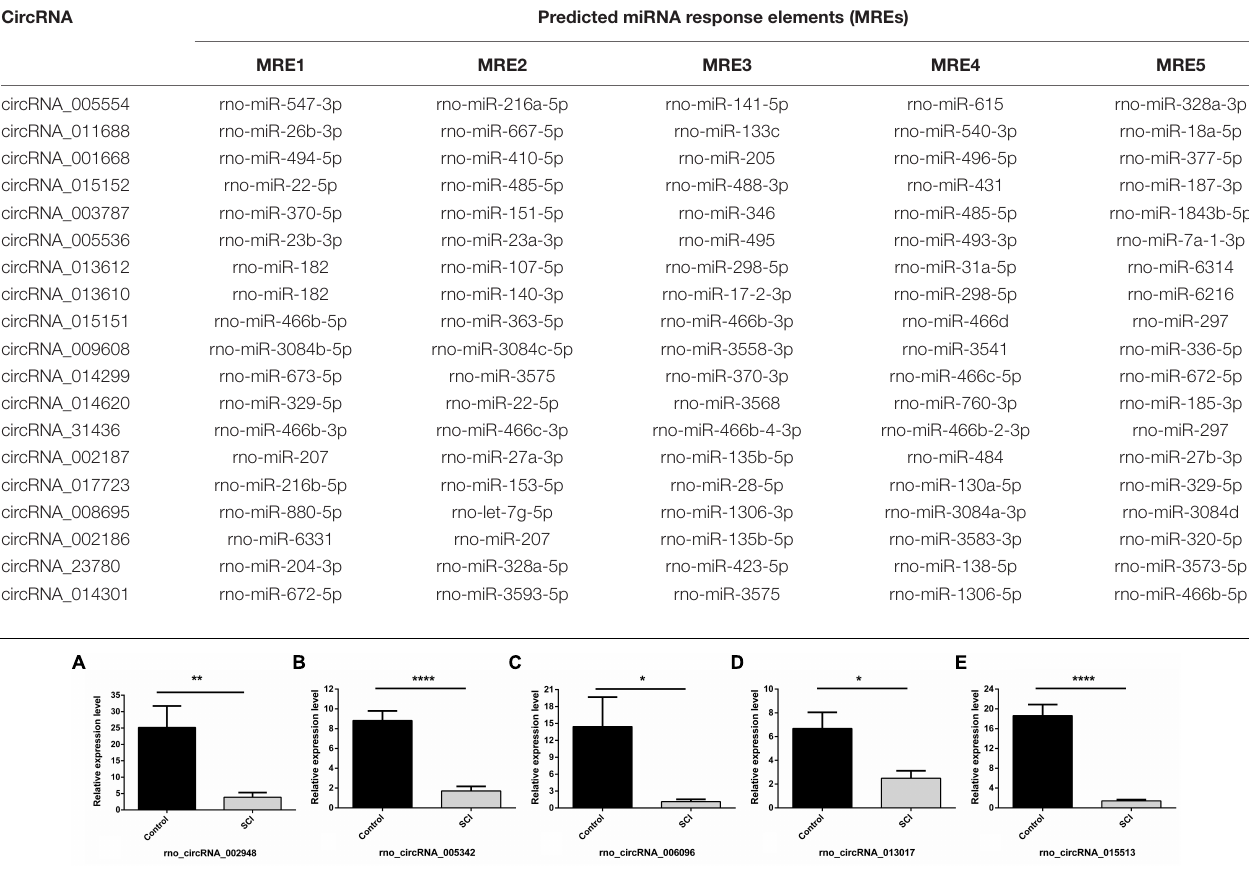
FIGURE 3 | Validation of five selected circRNAs using qRT-PCR. Compared with the sham control, rno_circRNA_005342, rno_circRNA_015513, rno_circRNA_002948, rno_circRNA_006096, and rno_circRNA_013017 in the SCI group were all significantly downregulated after SCI after validation by PCR assay in 12 samples (A–E). The data were normalized using the mean ± SEM ( n = 6 per group). ∗ P < 0.05, ∗∗ P < 0.01, ∗∗∗∗ P < 0.0001.